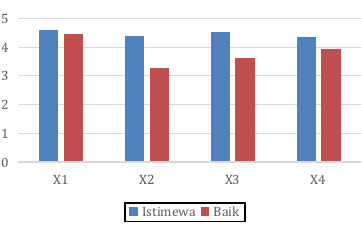
Figure 8. The chart bar